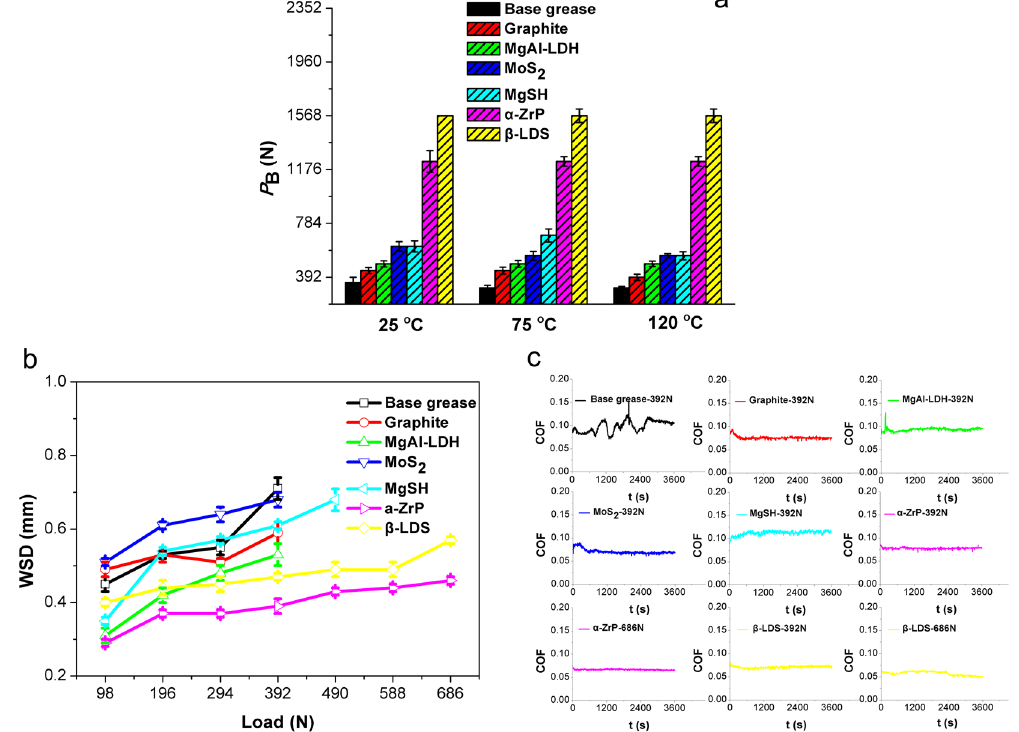
Figure 1. Friction and wear performance of various typical layered lubricant materials as additives in PAO8 lithium-based grease. ( a ) P B values at different temperatures (25, 75 and 120 °C). ( b ) WSD values under different loads (from 98 to 686 N). ( c ) Dynamic friction curves under standard load (392 N) and maximum applied loads of β -LDS and α -ZrP (686 N). Test conditions: four-ball test, P B : 1770 rpm, 10 s; WSD/COF: 1200 rpm, 3600 s, 75